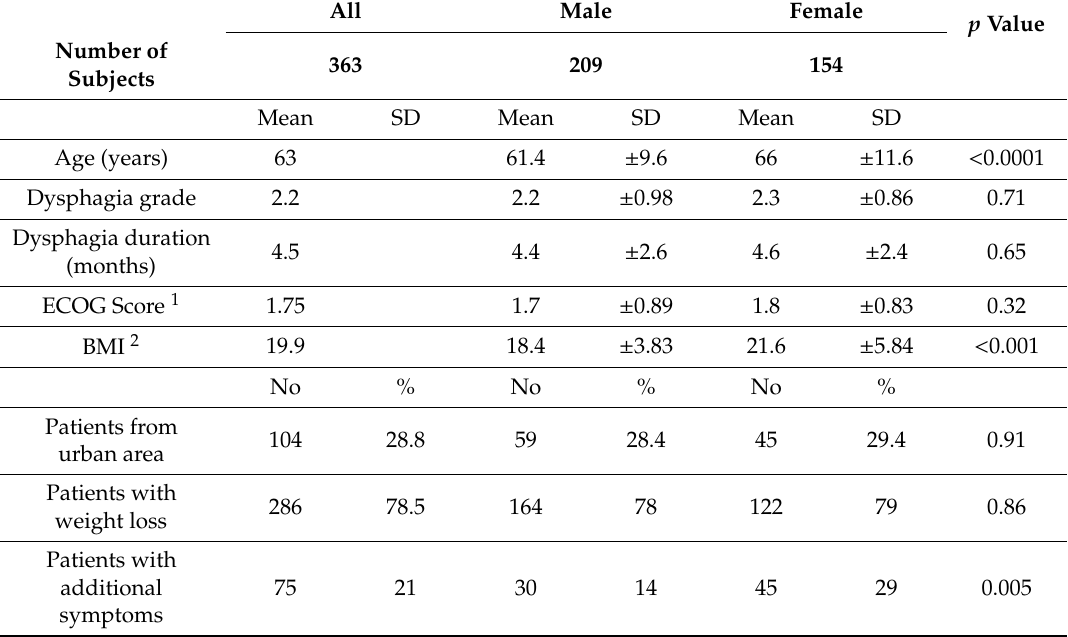
Table 1. Clinical characteristics of